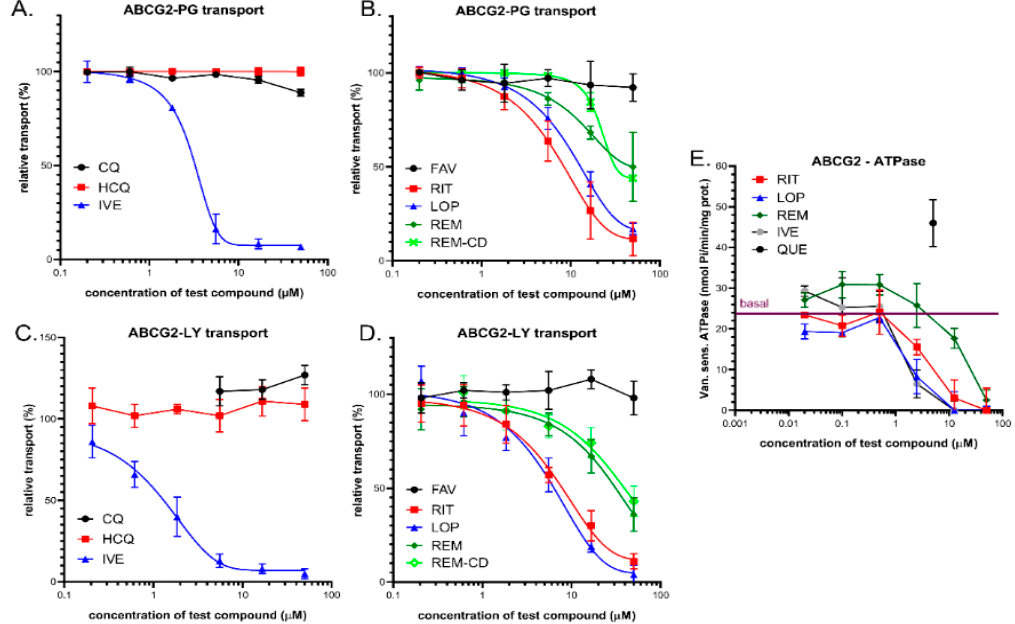
Figure 3. ( A , B ) Inhibition of ABCG2-mediated PhenGreen (PG)-AM extrusion in intact PLB-985 cells. Panel A: Effects of ivermectin (IVE), chloroquine (CQ), and hydroxychloroquine (HCQ). Panel B: Effects of lopinavir (LOP), ritonavir (RIT), favipiravir (FAV), remdesivir (REM), and SEBCD-remdesivir (REM-CD). ( C , D ) Inhibition of ABCG2-mediated lucifer yellow (LY) transport in the vesicular transport assay. ( E ) ABCG2-ATPase activity in isolated Sf9 membrane vesicles. Effects of ivermectin, lopinavir, ritonavir, and remdesivir. Maximum ATPase stimulation was obtained by 5 µ M quercetin. Data on the graphs show the average of at least three independent experiments, +/ − SD ( A , B ) or SEM ( C – E ) values.